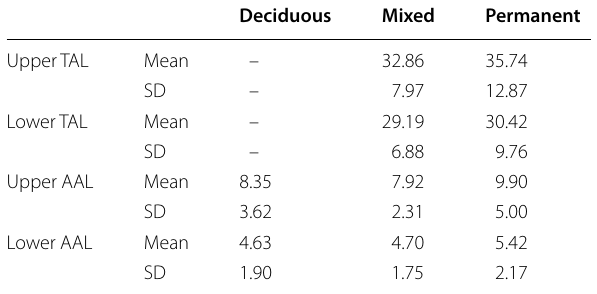
Table 1 Mean and standard deviation of total arch length and anterior arch length in upper and lower arches in deciduous, mixed, and permanent dentitions